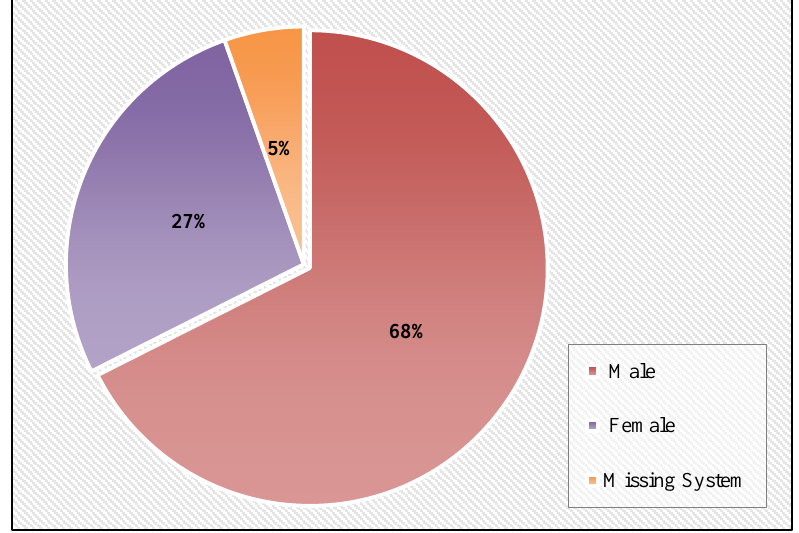
Figure 2. Gender of the